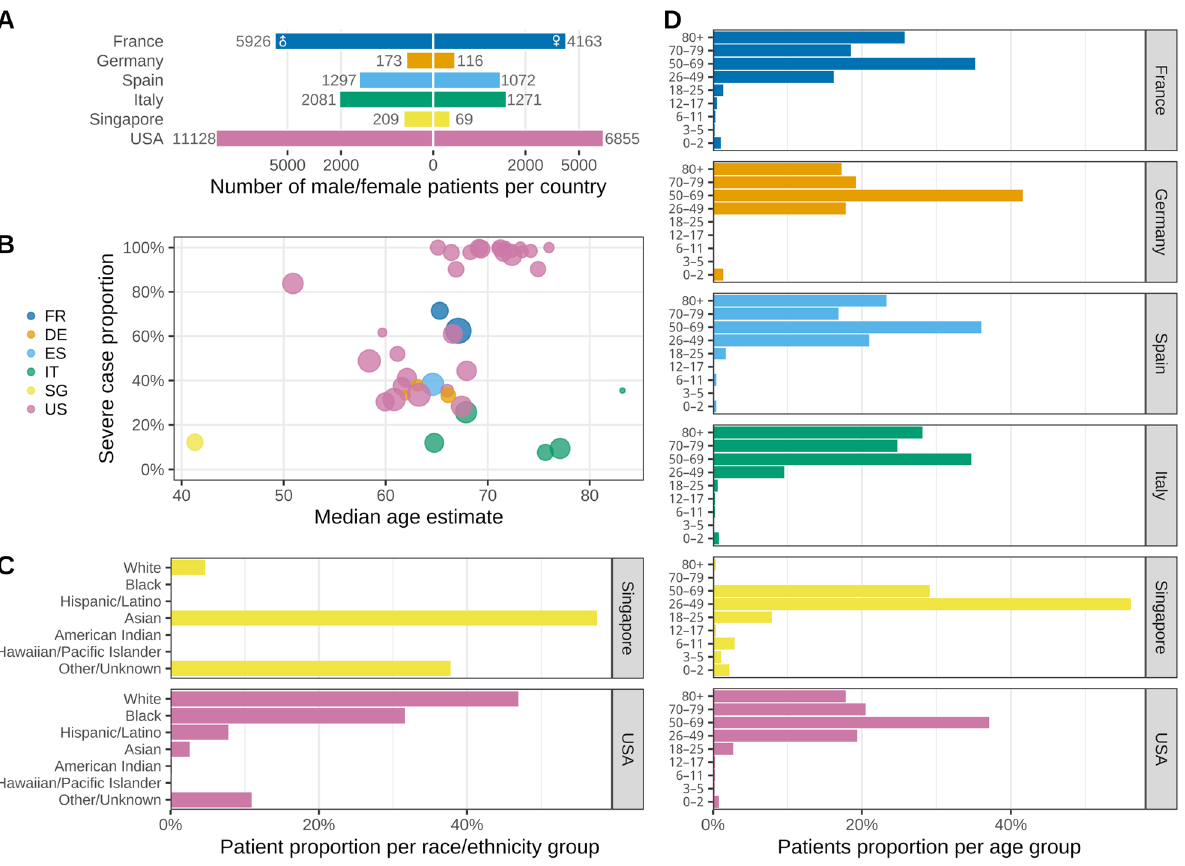
Figure 2. Characteristics of the study population across healthcare systems and countries. ( A ) Total number of male (left) and female (right) patients grouped by country shown in square-root scale. ( B ) Proportion of ever- severe cases by median age estimate at each healthcare system, grouped by country. Node size corresponds to the total number of patients per system. ( C ) Distribution of self-identified race among patients at healthcare systems in Singapore and the United States. The Other/Unknown category includes patients who did not identify with any of the predefined race categories and/or whose data were not reported. Most European healthcare systems did not report race. ( D ) Average proportion of patients in each age group within each country. FR, France; DE, Germany; ES, Spain; IT, Italy; SG, Singapore; US(A), United States of after admission (Fig. 3, eFig. 1). Similarly, 84% of healthcare systems reported an increase in the proportion of patients with “Other disorders of the brain” (ICD-10 G93, including “encephalopathy”, “cerebral edema”, “brain table). The proportion of patients with “epilepsy and recurrent seizures” (ICD-10 G40), “encephalitis, myelitis, and encephalomyelitis” (ICD-10 G04) and “other and unspecified myopathies” (ICD-10 G72) increased after admission, but these findings were not significant after adjusting for multiple testing. Likewise, none of the other neurological conditions showed a statistically significant difference in prevalence after admission. To assess the association with COVID-19 severity, we next used Fisher’s exact test to examine the enrichment or depletion of each neurological condition among patients hospitalized for COVID-19 who ever experienced severe disease based on the published 4CE COVID-19 severity criteria 30 , using those who never experienced severe disease as the comparator (Fig. 4). A positive log 2 value of enrichment (LOE) value denoted a higher proportion of severe cases for a given neurological condition than the never-severe cases, while a negative LOE value indicated the opposite. For instance, a LOE value of 0.283 for ICD code R41 meant that the observed number of severe cases with R41 (disorder of consciousness) was 2 0.283 or ~ 1.22 times higher than the expected number of severe cases for R41, which was equivalent to a 22% increase in relative risk ( i.e., relative risk difference RRD = 22%). Table 1 listed the neurological phenotypes that exhibited statistically significant associations with severe COVID-19 status ( p FDR < 0.05). The interactive data table (https:// covid clini cal. github. io/ Phase1. 1Neur oRCode/ 01- analy sis- icd10. html# enric hment_ tab) and the results directory of the project online data repository (https:// github. com/ covid clini cal/ Phase1. 1Neur oRCode/ tree/ master/ resul ts) listed the LOE, 95% confidence intervals and p values for all neurological conditions examined. In the period after hospital admission for COVID-19, using the patients who never experienced severe COVID-19 as reference, a significantly higher proportion of patients with severe disease had “other symptoms and signs involving cognitive functions and awareness” (ICD-10 R41: RRD after = 22%), “other cerebrovascular